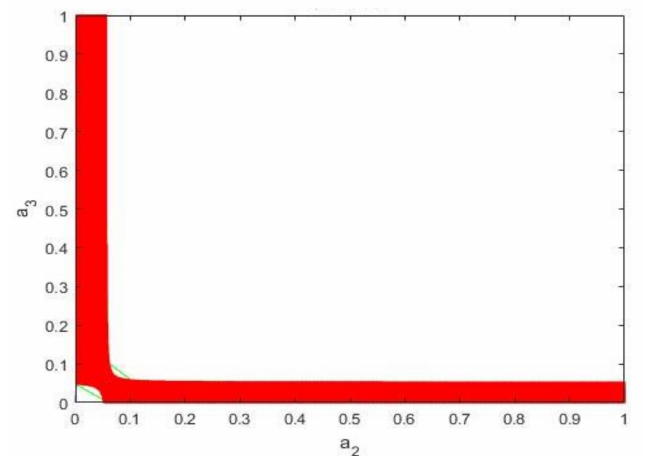
Figure 2. The stable region of the Nash equilibrium point in-plane ( α 2 , α 3 ) , α 1 = 0.84.